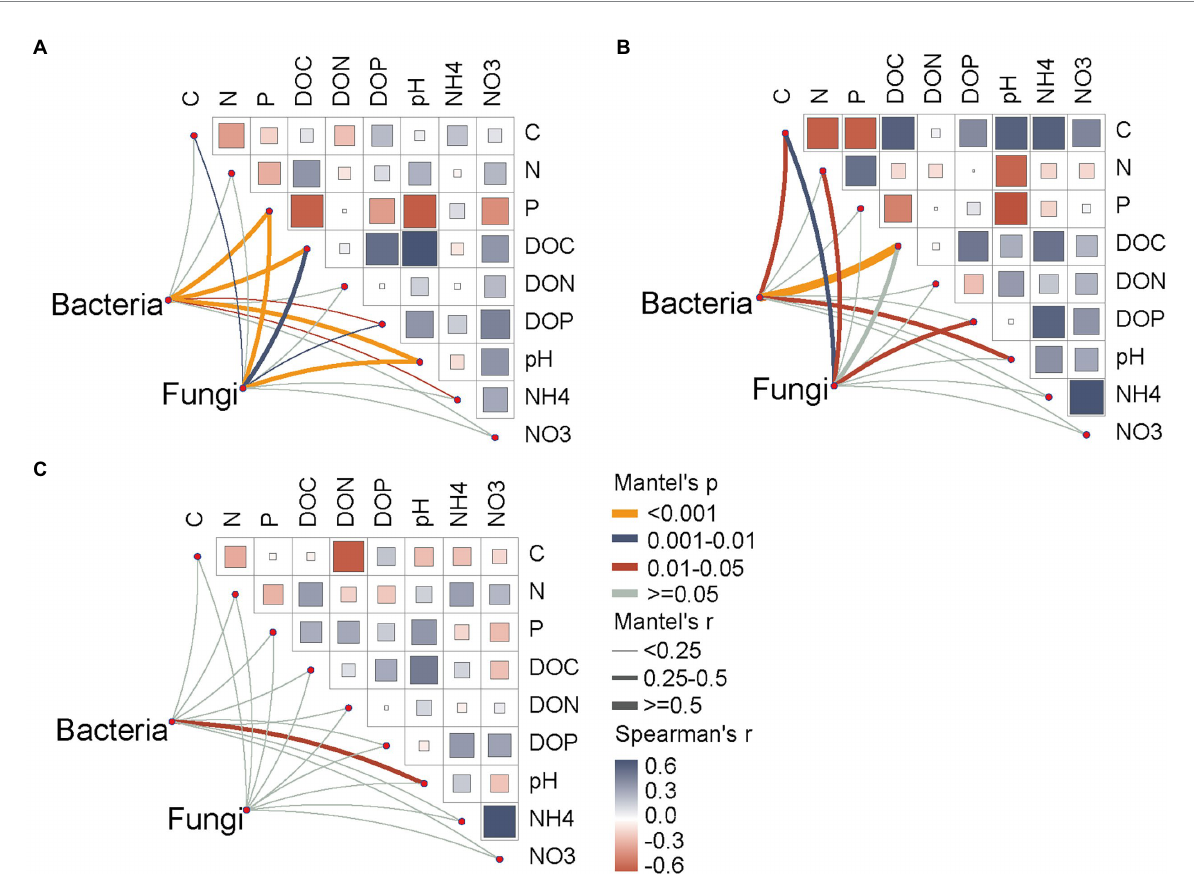
FIGURE 6 Total and dissolved organic drivers of the soil bacterial and fungal community compositions. (A) all seasons; (B) wet season; (C) dry season. Soil microbial community composition was correlated to soil variables by partial Mantel tests based on the Bray–Curtis distance. Pairwise comparisons of total and dissolved organic parameters are shown at the upper-right, with a color gradient representing Spearman’s correlation coefficients. The edge width represents the partial Mantel’s r statistic for the corresponding correlation, and edge color denotes that significance are tested based on 999 permutations. NO3, nitrate nitrogen; NH4, ammonium nitrogen; DOC, dissolved organic carbon; DON, dissolved organic nitrogen; DOP, dissolved organic